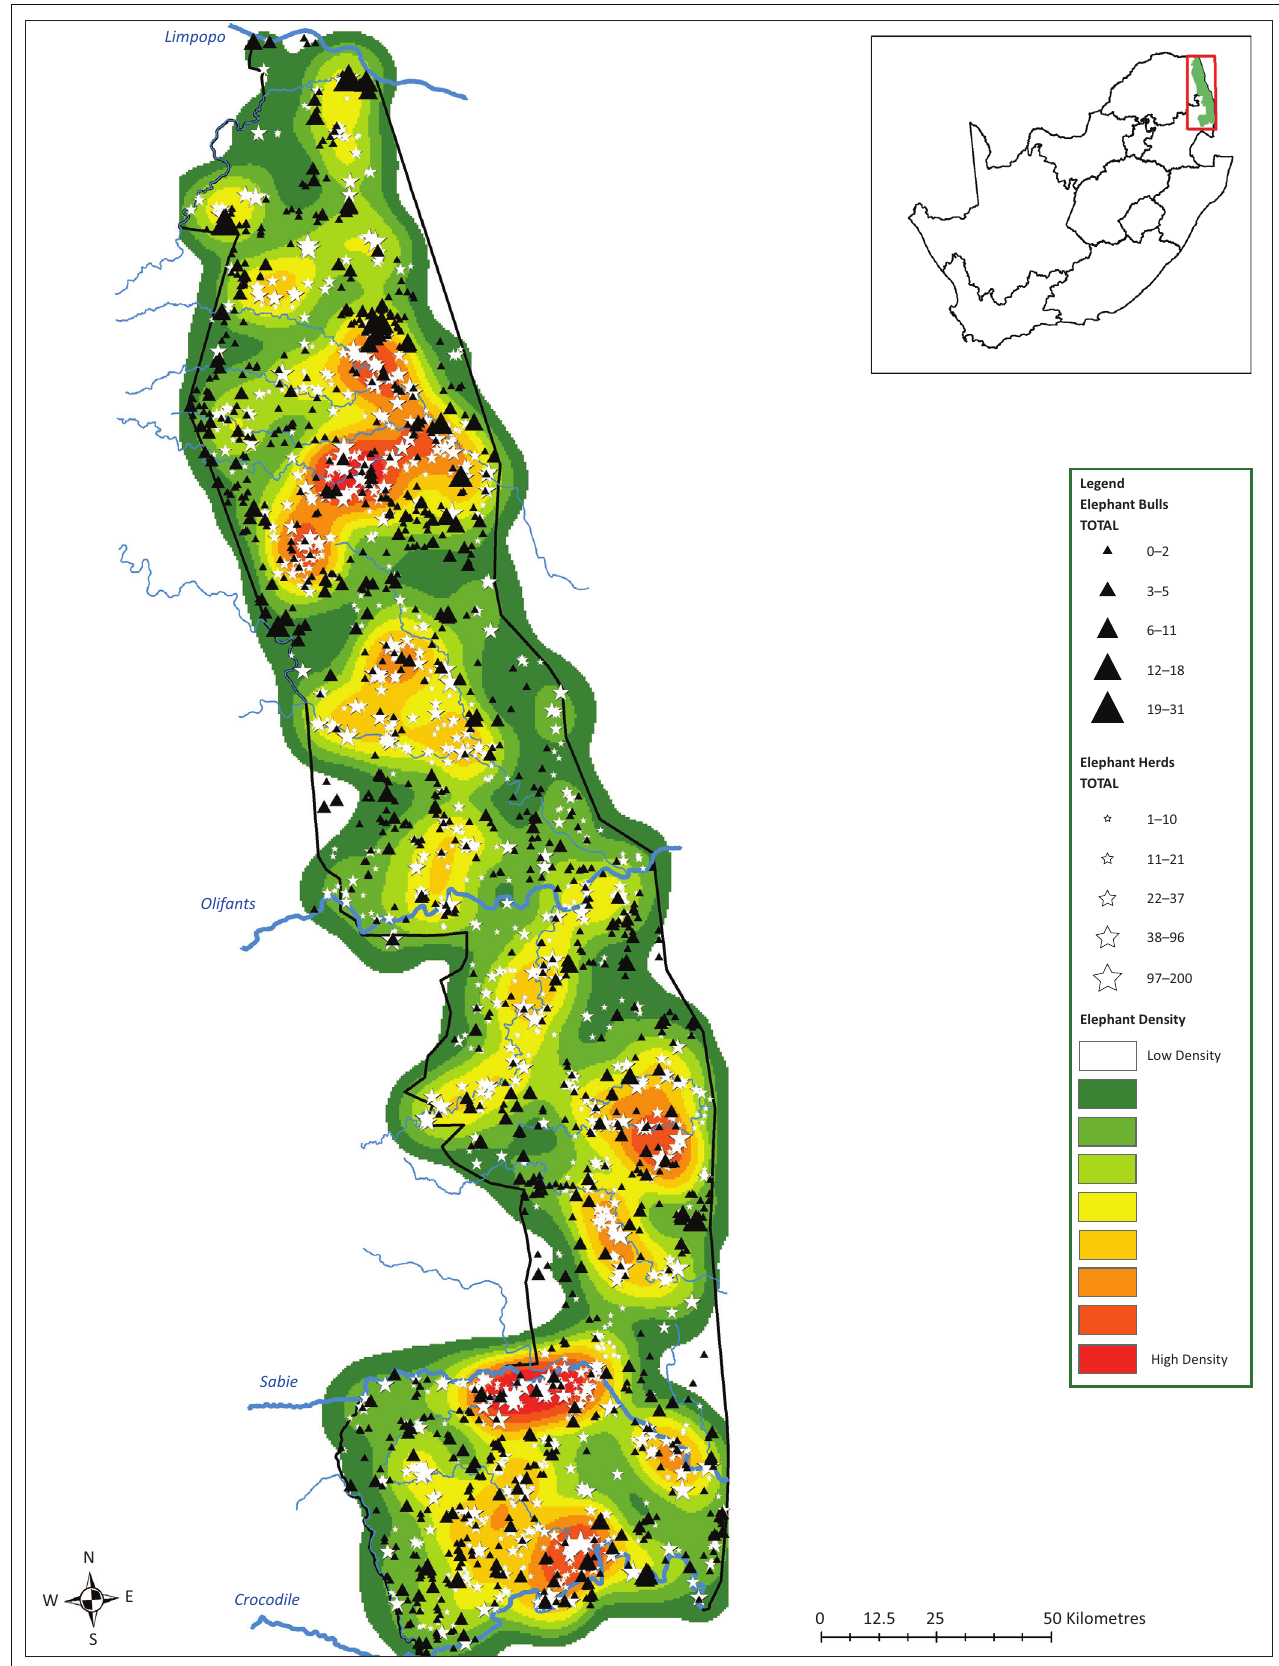
FIGURE 1: The distribution of elephants recorded during the survey of the Kruger National Park in